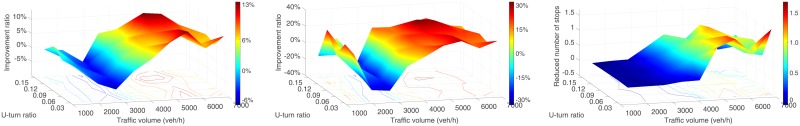
Sensitivity analysis of flow 3, WE through vehicles.The X axis is different traffic volumes, the Y axis is U-turn ratio and the Z axis is improvement ratio (Ratio = (MUTI-ESUL)/MUTI*100%) in a,b, and reduced times (Reduced times = MUTI-ESUL) in c. a. Travel time improvement ratio. b. Delay improvement ratio. c. Reduced number of stops.